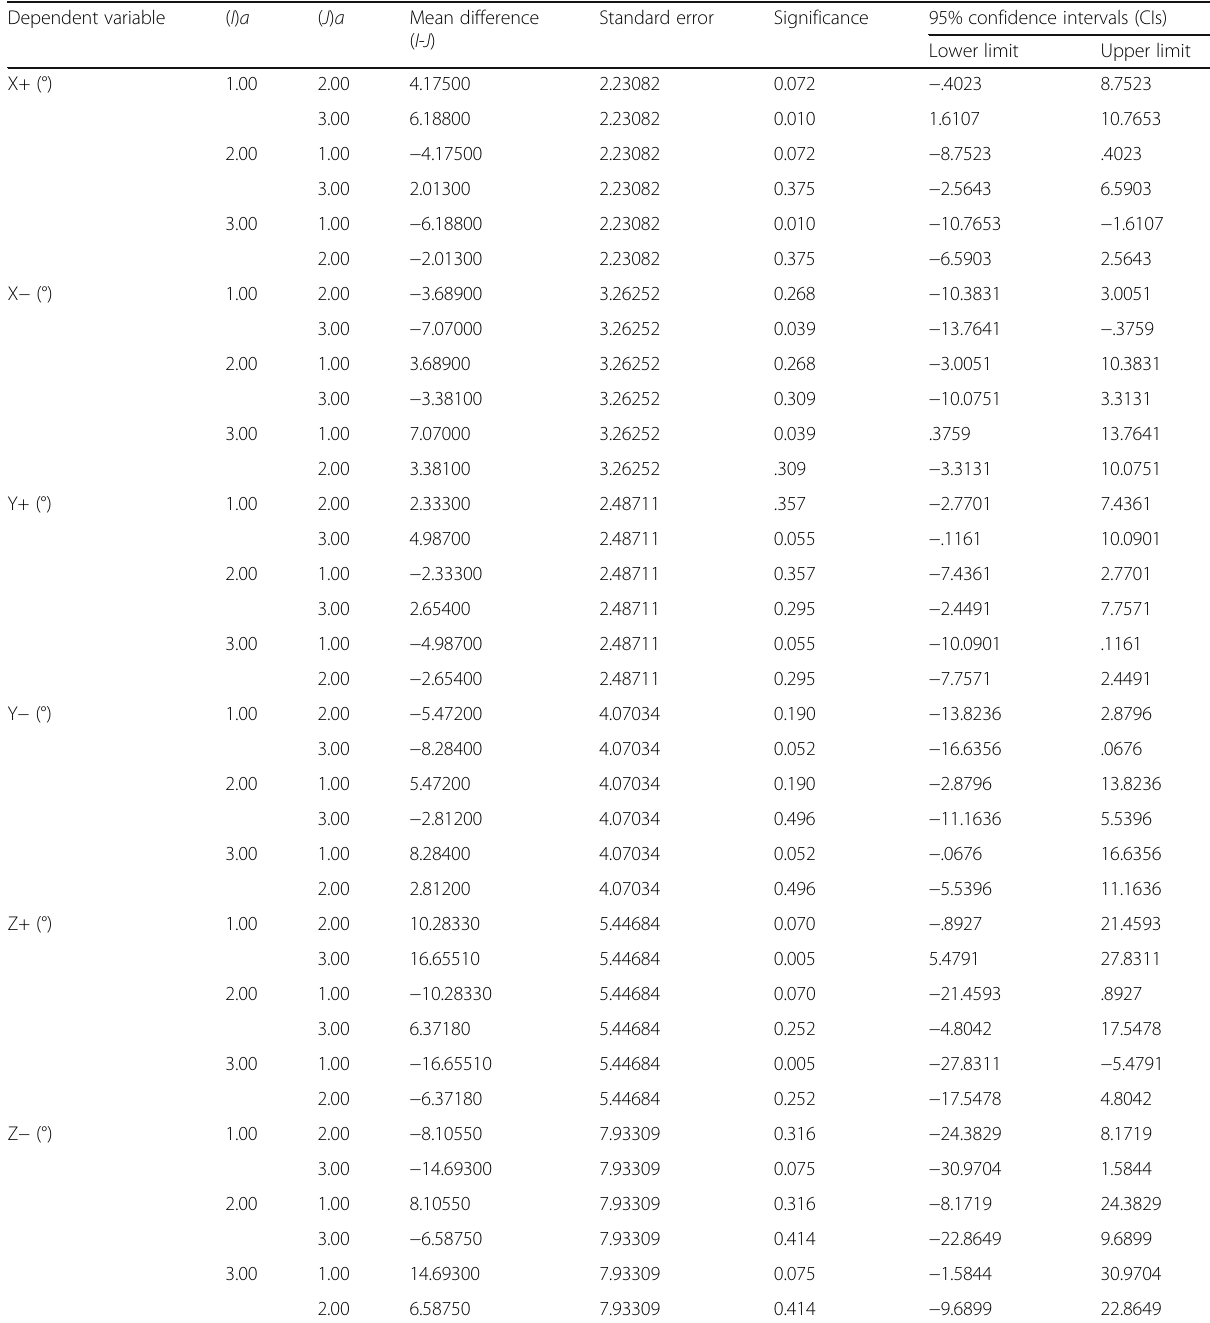
Table 5 LSD multiple comparison results of experimental data of virtual object velocity Dependent